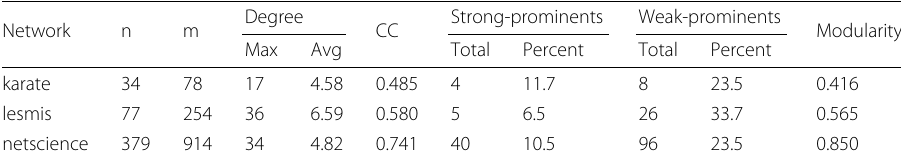
Table 1 Properties of small networks Network